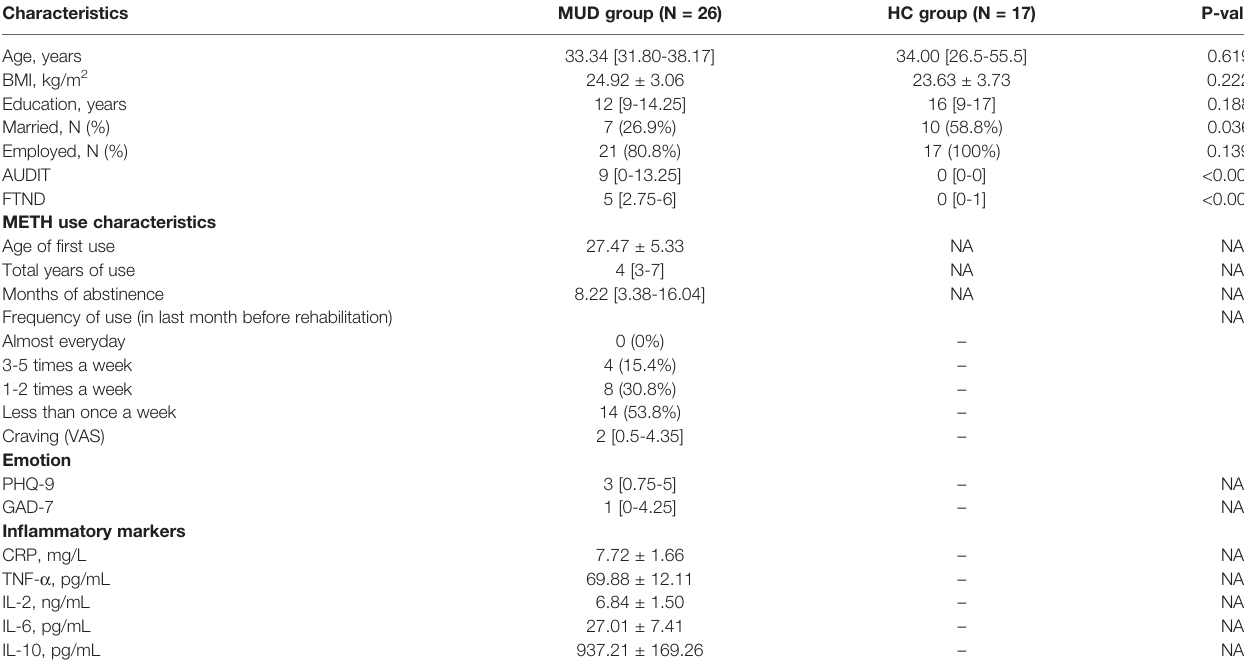
TABLE 1 | Demographic and clinical characteristics of study